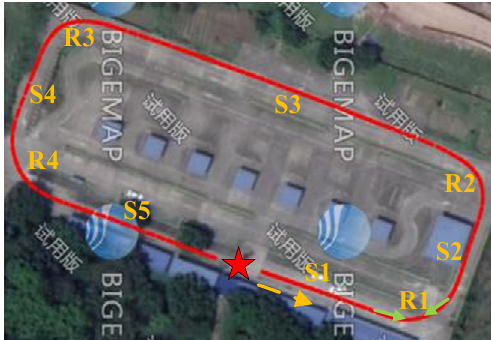
Figure 6. Driving experimental scenarios.